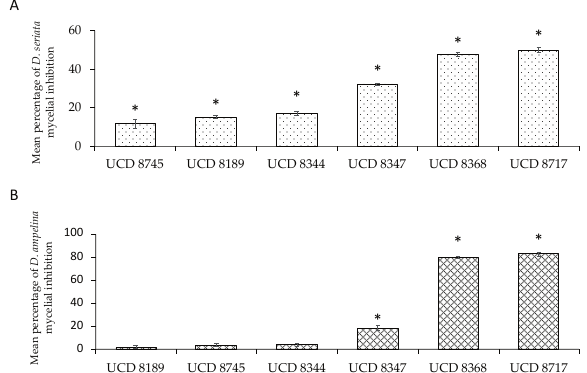
Figure 2. In vitro dual culture evaluation of selected microorgan- isms’ ability to inhibit radial mycelial growth of the grapevine trunk disease pathogens (A) Diplodia seriata and (B) Diaporthe ampelina. Asterisk (*) indicates significant inhibition in comparison with a control (Dunnett’s test P ≤